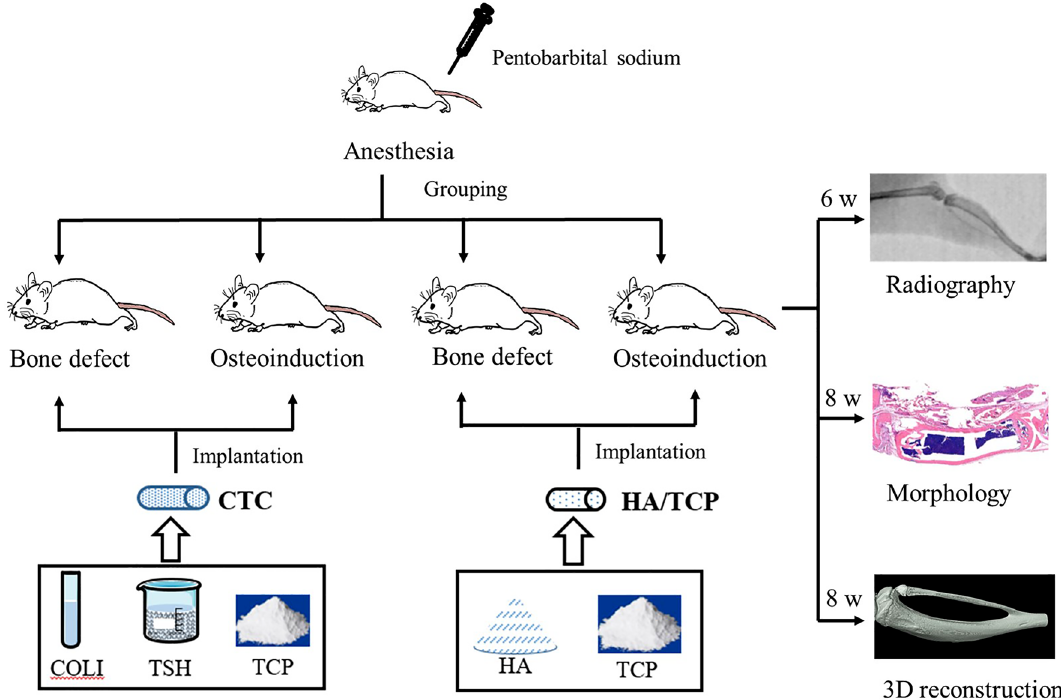
Figure 1. The overall idea of the experiment of this